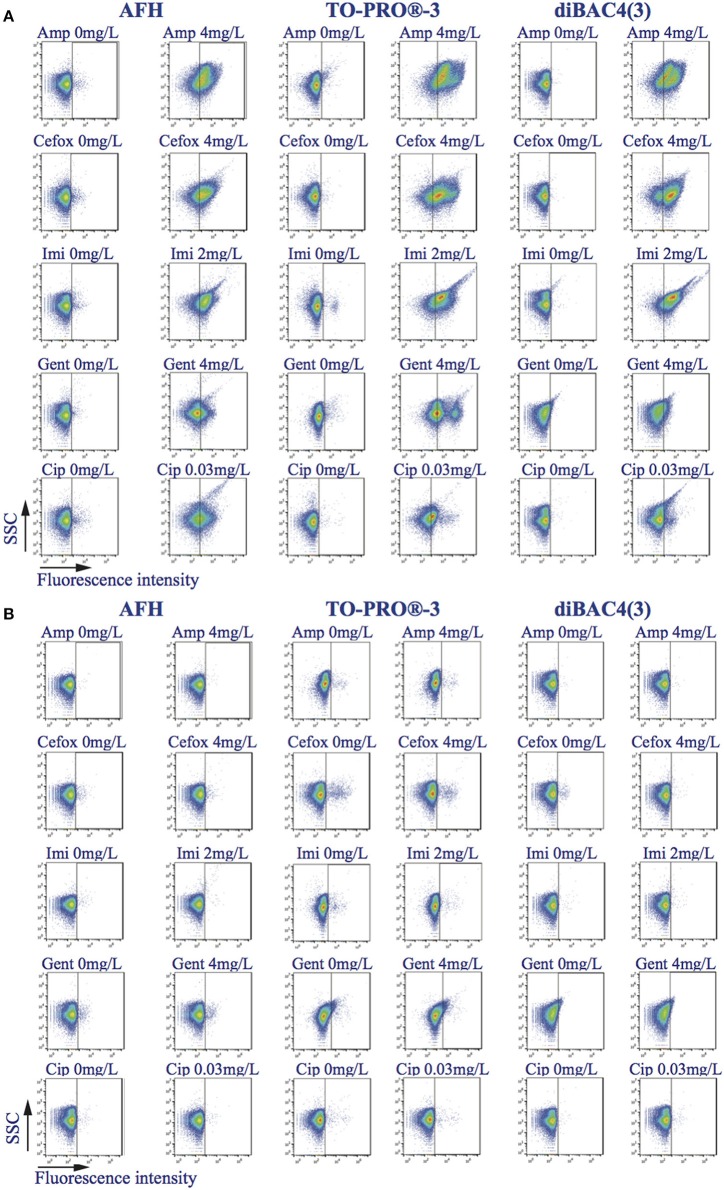
Effects of antibiotics on the light scatter SSC and fluorescence intensity distribution. Density-plots SSC vs. fluorescence intensity of bacterial samples treated, or not, with ampicillin, cefoxitin, imipenem, gentamicin, and ciprofloxacin, during 2 h and stained with AFH, TO-PRO®-3, and DiBAC4(3). The vertical bars in the density-plots of the untreated samples and the density-plots of the treated samples are at the same place. (A)
E. coli ATCC25922 strain, which is sensitive to all the studied antibiotics. (B)
E. coli strains resistant to the one of the tested antibiotics.